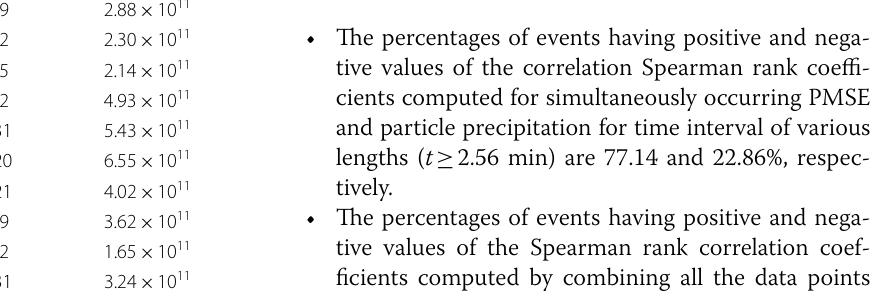
(m − 3 ) for events e